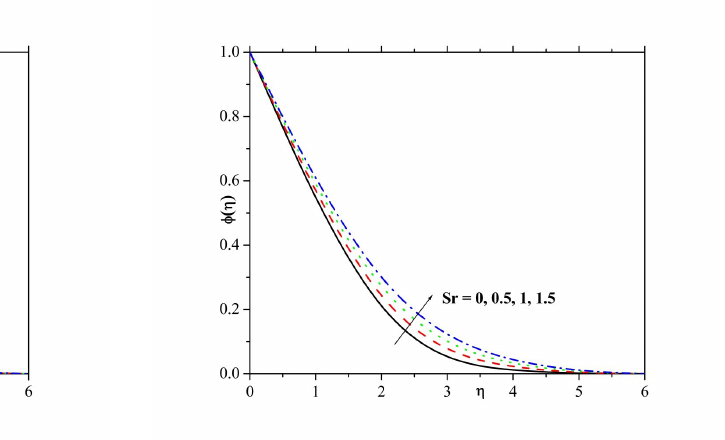
Fig. 10: Influence of Sr on ϕ ( η ) .